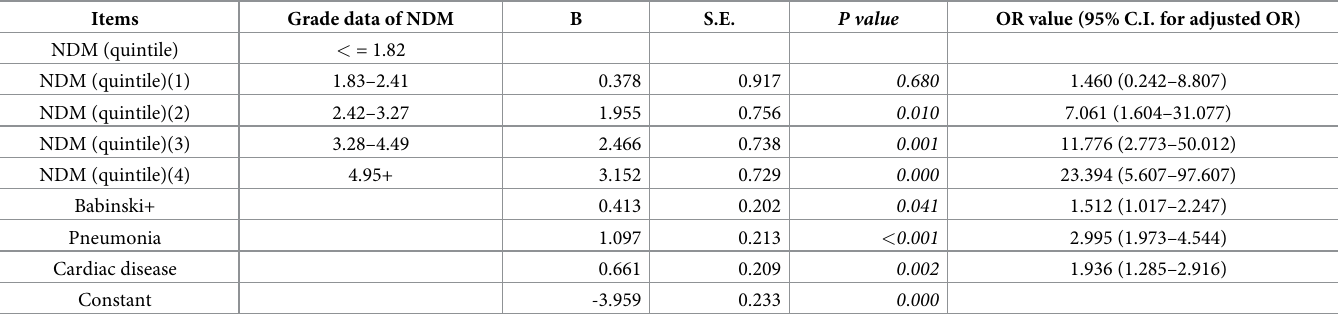
Table 3. Regression analysis result of NDM (quintile) combined with pneumonia to the poor prognosis of